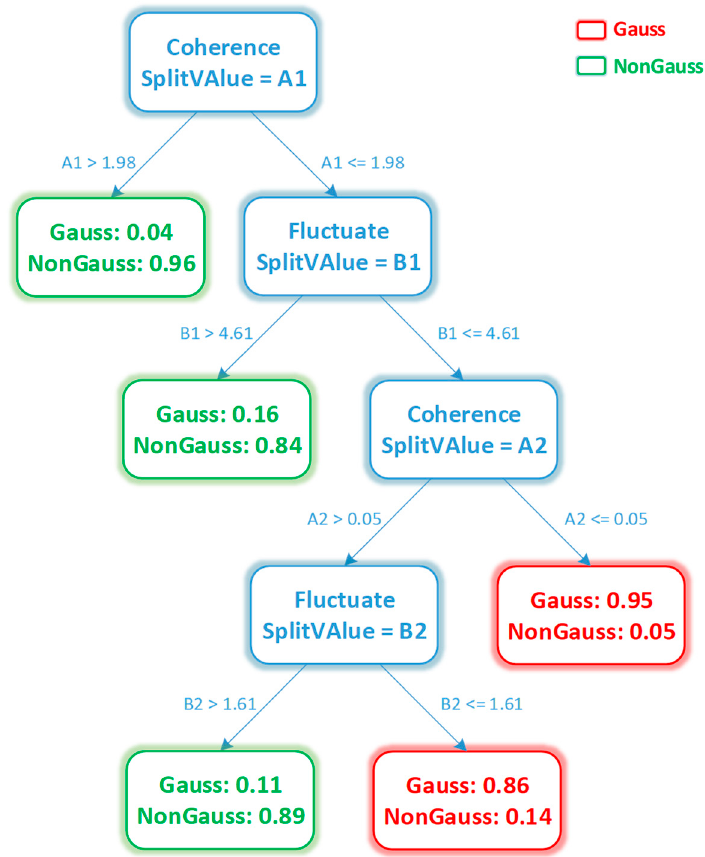
Figure 5. Tree diagram for the decision tree. A stands for the consistency feature, and B stands for the fluctuation feature. The red end nodes indicate that the input data are Gaussian, while the green end nodes mean that the input data are non-Gaussian.